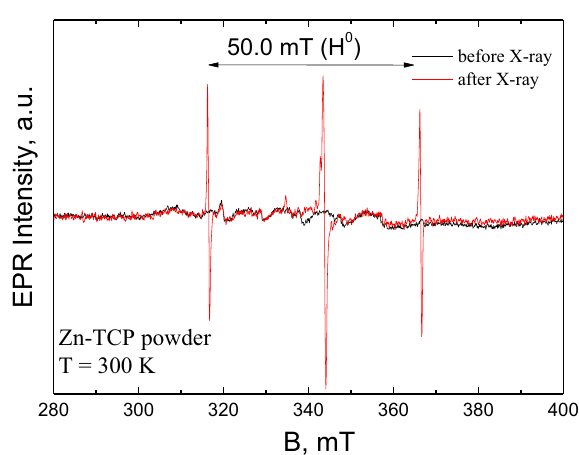
Fig. 3 Comparison of EPR spectra for Zn-TCP powder sample annealed at 900 °C before and after X-ray irradiation